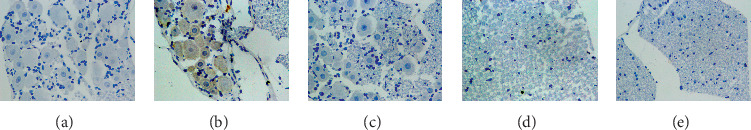
Substance P expression in the dorsal root ganglia. Note: substance P expression was measured after treatment for 30 days (×400). (a) Group N. (b) Group Mo. (c) Group L. (d) Group M. (e) Group H.